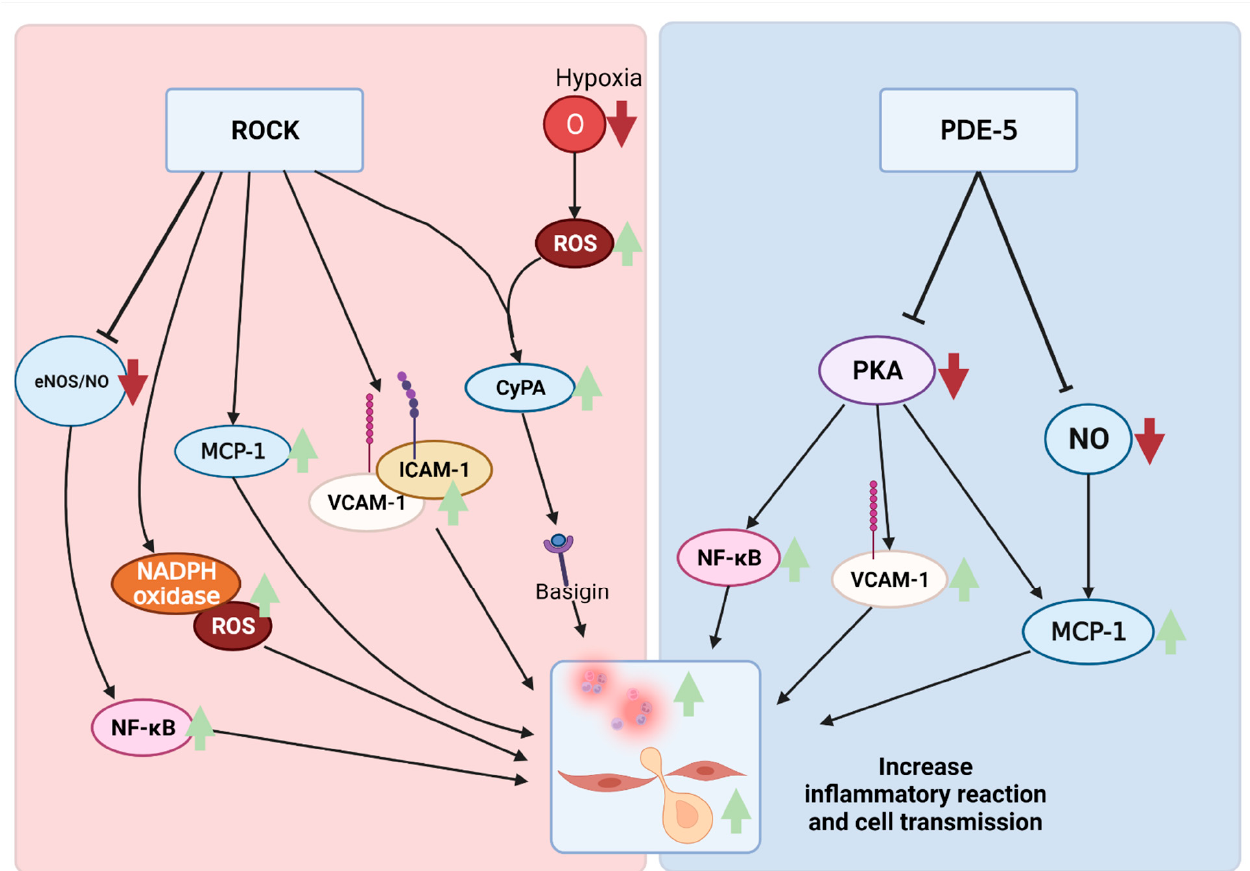
Figure 2. Improvement of the inflammatory response and recruitment of inflammatory cells due to various factors in the ROCK and PDE family. CyPA: cyclophilin A; ICAM-1: intercellular adhesion molecule 1; MCP-1: monocyte chemoattractant protein 1; NF- κ B: nuclear factor kappa-light-chain- enhancer of activated B cells; NO: nitric oxide; PDE-5: phosphodiesterase-5; PKA: protein kinase A; ROCK: rho-associated protein kinase; ROS: reactive oxygen species; VCAM-1: vascular cell adhesion molecule 1.